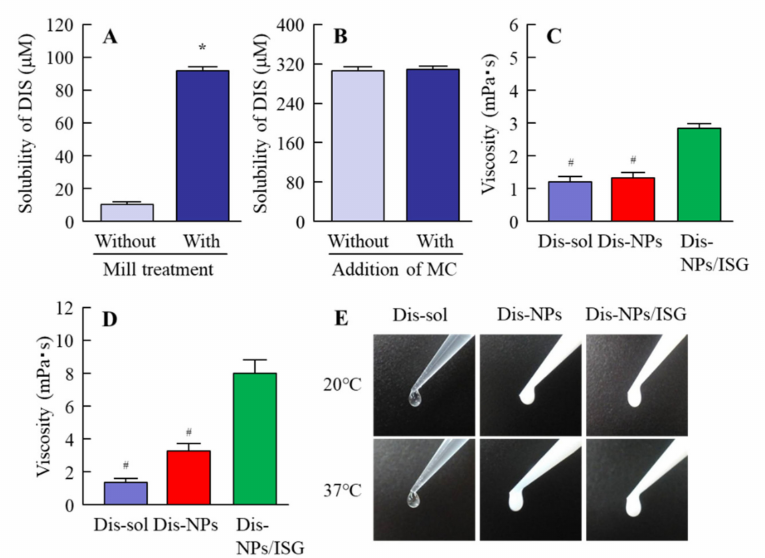
Figure 2. Solubility and viscosity of DIS in ophthalmic DIS formulations. A : Changes in DIS solubility in ophthalmic DIS formulations with or without the bead mill treatment. B : E ff ect of methylcellulose (MC) content on DIS solubility in ophthalmic Dis-NPs formulations. C and D : Viscosity of the disulfiram solution (Dis-sol), Dis-NPs, and Dis-NPs / ISG at 20 ◦ C ( C ) and 37 ◦ C ( D ). ( E ) Pictures of the Dis-sol, Dis-NPs, and Dis-NPs / ISG at 20 and 37 ◦ C. The composition of the Dis-sol, the Dis-NPs, and the Dis-NPs / ISG is shown in Table 1. n = 9. * p < 0.05 vs. the group without mill treatment. # p < 0.05 vs. the Dis-NPs / ISG for each category. Although the solubility of DIS in the group with MC and the group the Dis-NPs / ISG became gel at 37 ◦ C, and the viscosity had